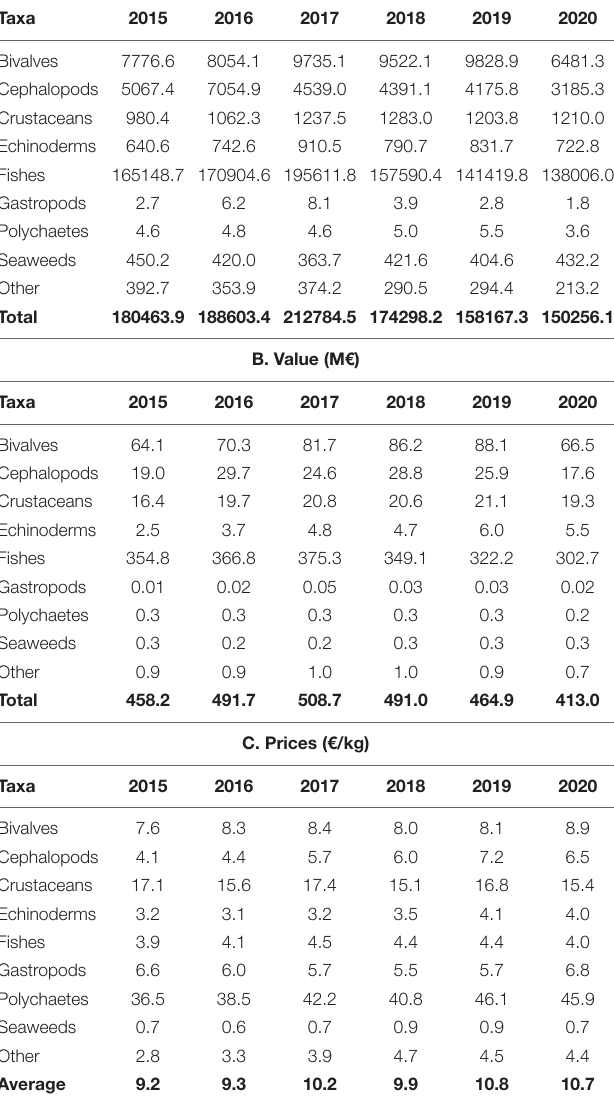
TABLE 1 | Annual landings in (A) volume (t), (B) sale value (M€), and (C) prices (€/kg) by main biological groups between 2015 and 2020 in Galicia. A. Volume